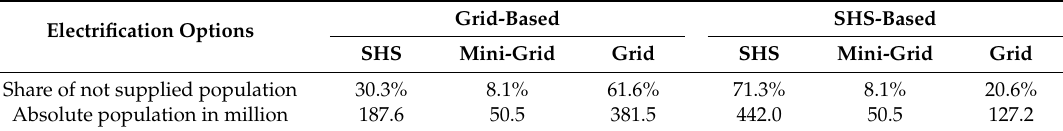
Table 3. Quantification of electrification options depending on excluding (grid-based) and including (SHS-based) the population density within the grid buffer zone based on the planned grid infrastructure.